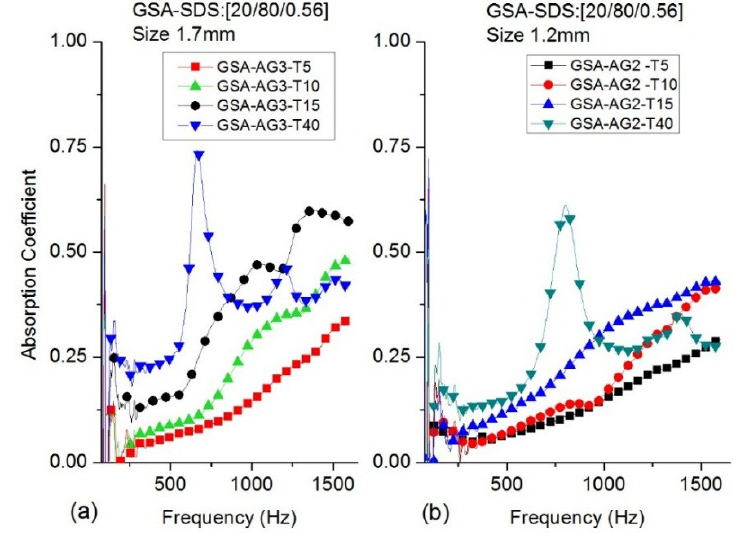
Figure 4. Absorption coefficients for GSA–SDS composites thickness T5–T40 ( a ) size 1.7 mm; ( b ) size 1.2 mm for frequency (50–1600Hz).